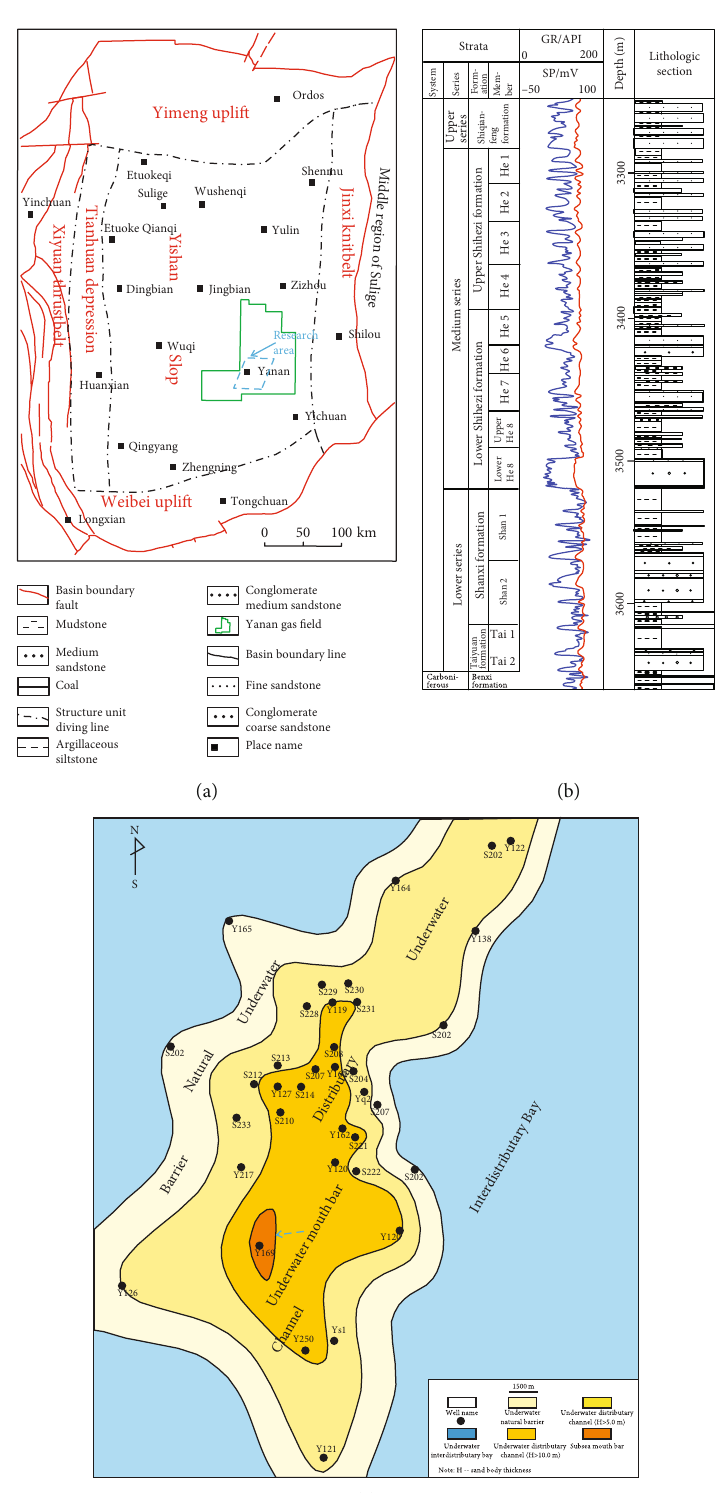
Figure 1: (a) Location of the research area. (b) Well logs of the Shanxi Formation. (c) Sedimentary characteristics of the research area (modi fi ed from [26,